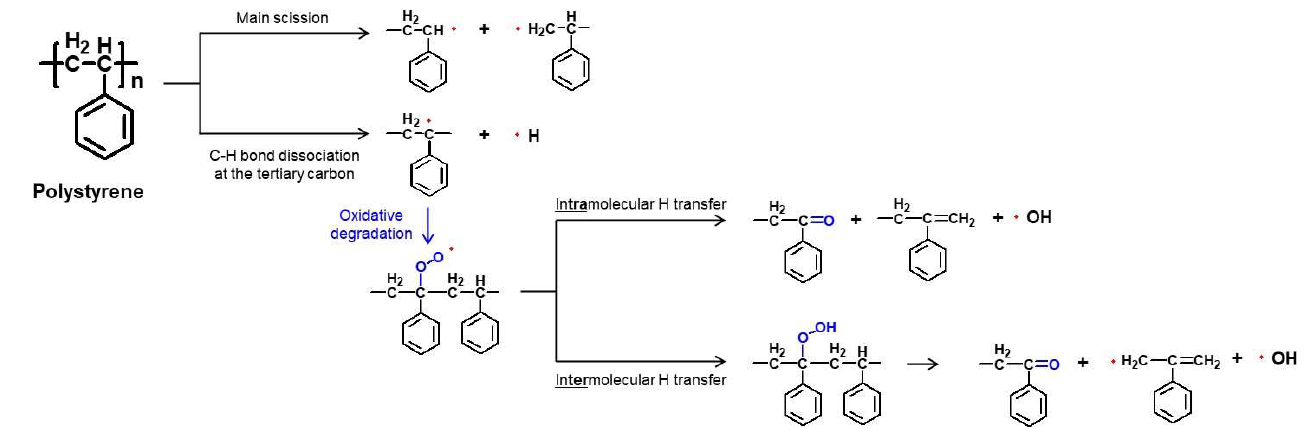
Figure 6. Schematic representation of formation of typical PS radiolysis products on irradiation.